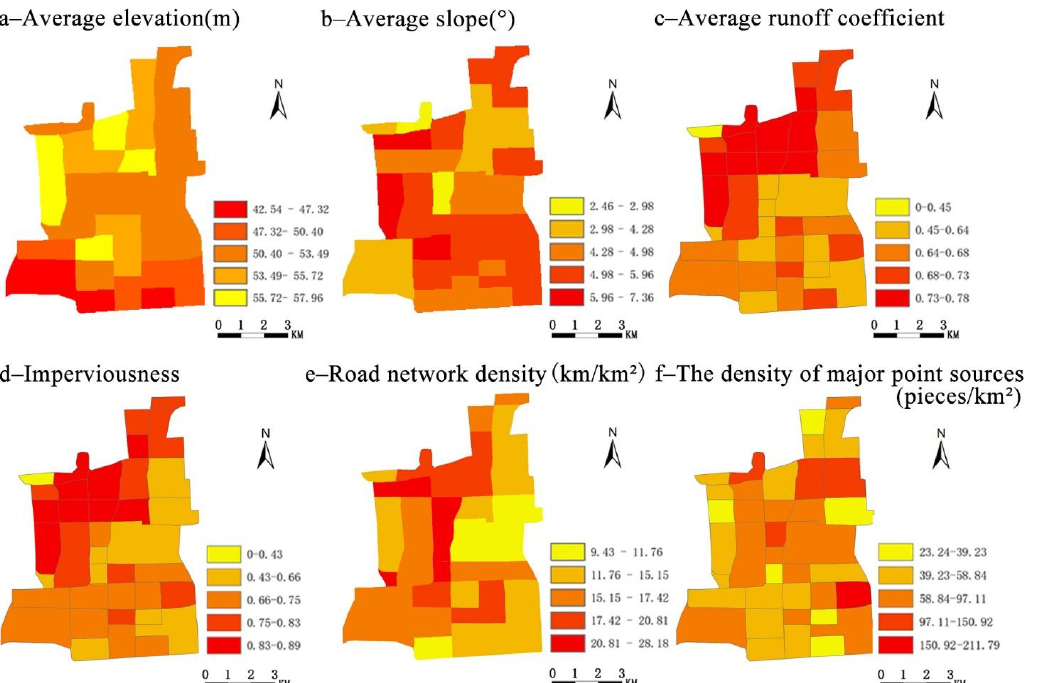
Figure 5. Calculation results of specific indicators of the classification and evaluation system of the land plots. ( a ) Average elevation in each plot, ( b ) average slope in each plot, ( c ) average runoff coefficient in each plot, ( d ) imperviousness in each plot, ( e ) road network density in each plot, ( f ) the density of major point sources in each plot. Table 4. Difference comparison results of a cluster category analysis of variance.